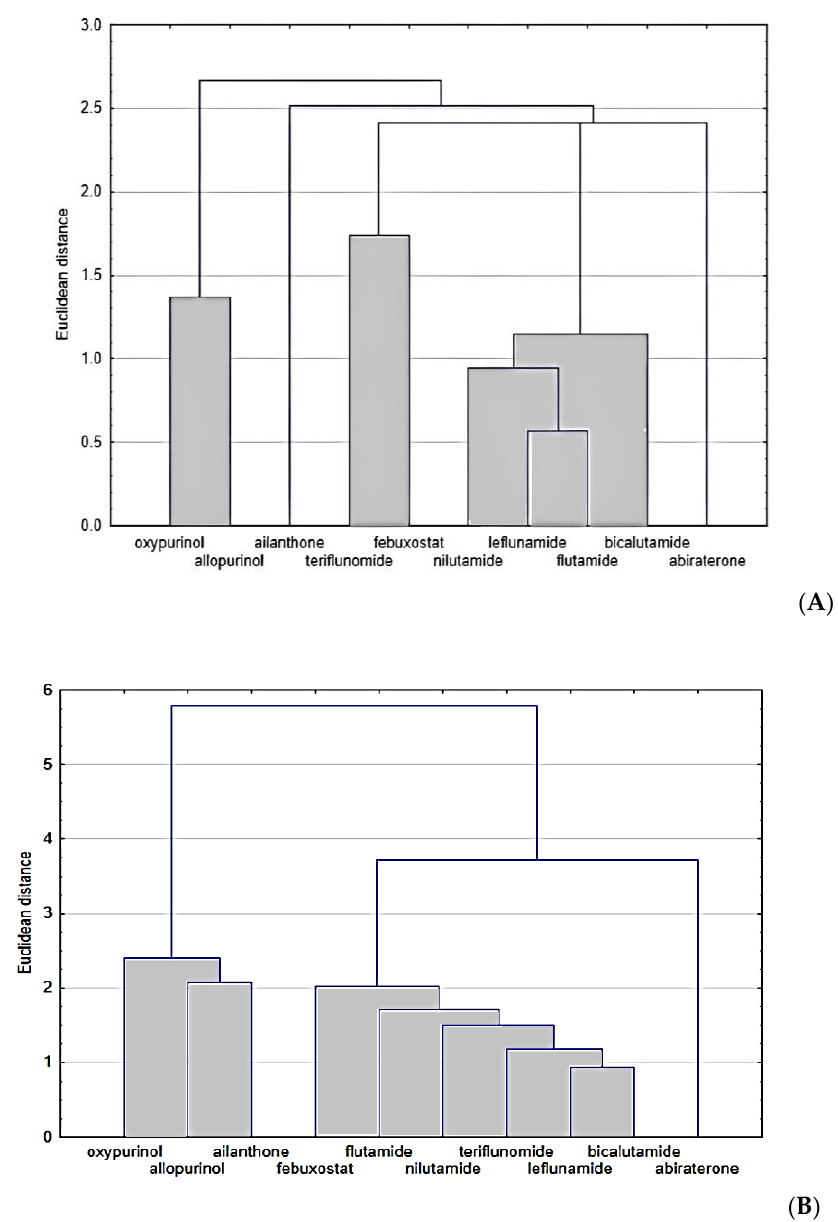
Figure 3. Similarity analysis of tested compounds based on their experimentally determined parameters of lipophilicity ( A ) and theoretical logP ( B ).